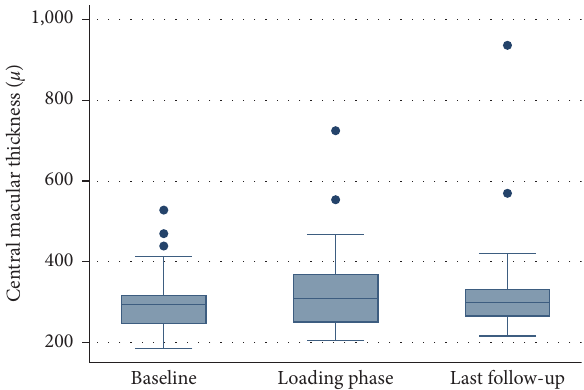
Figure 2: Boxplot analysis illustrates central macular thickness in μ m at the analyzed timepoints. The ordinate shows central macular thickness in μ m for the eyes at baseline prior to treatment switch (left side), after the loading phase which is three injections of bevacizumab (middle), and at last available follow-up visit (right side) shown on the abscissa. Statistically significant results (pair- wise comparison Wilcoxon test, p < 0 . 05) are marked with an asterisk.